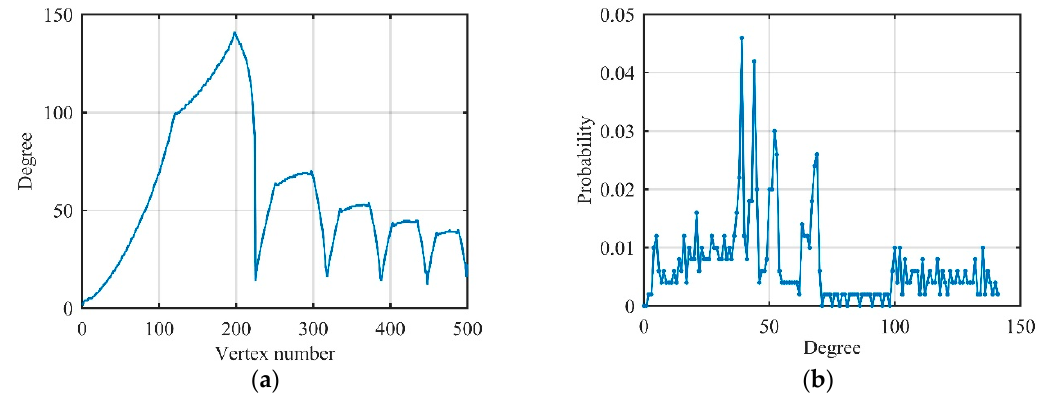
Figure 7. Related degree features of linear frequency modulation (LFM) signal on visibility graphs. ( a ) Degree of each vertex; ( b ) degree distribution.